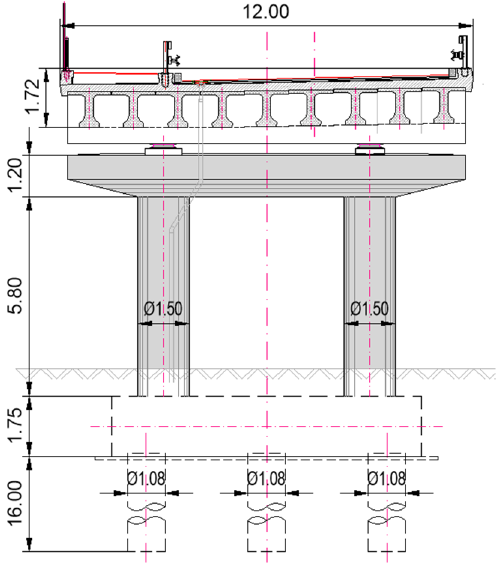
Figure 3. Superstructure cross section and pier front view [49].